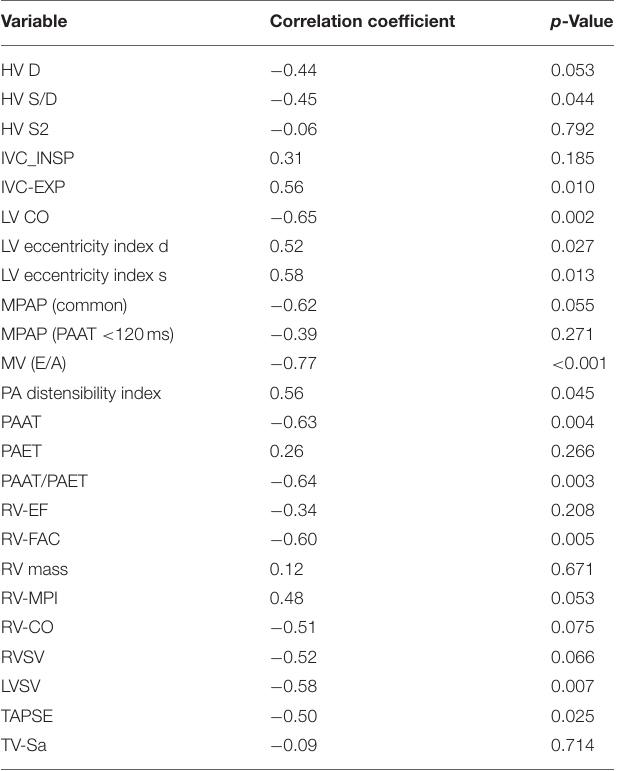
TABLE 1 | Correlation of echocardiographic variable with right ventricular systolic pressure (RVSP).